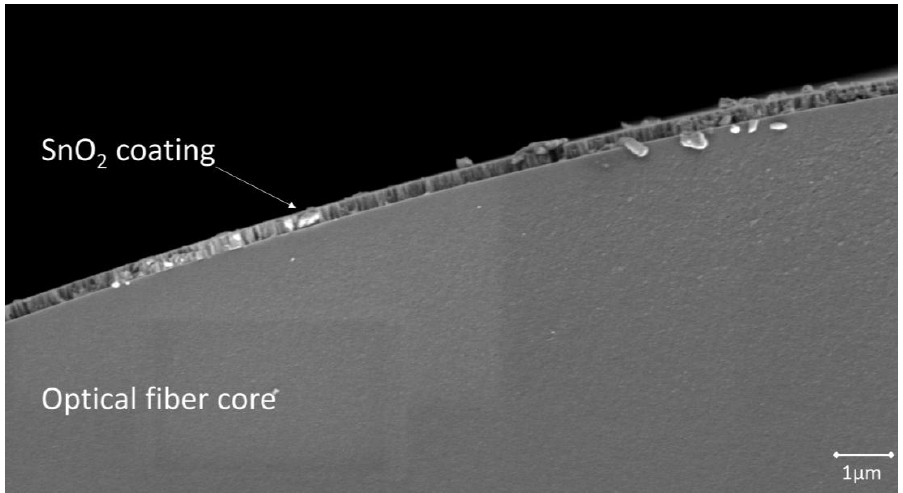
Figure 2. SEM image of S0 cross section. A homogeneous SnO 2 coating can be clearly distinguished from the optical fiber core.